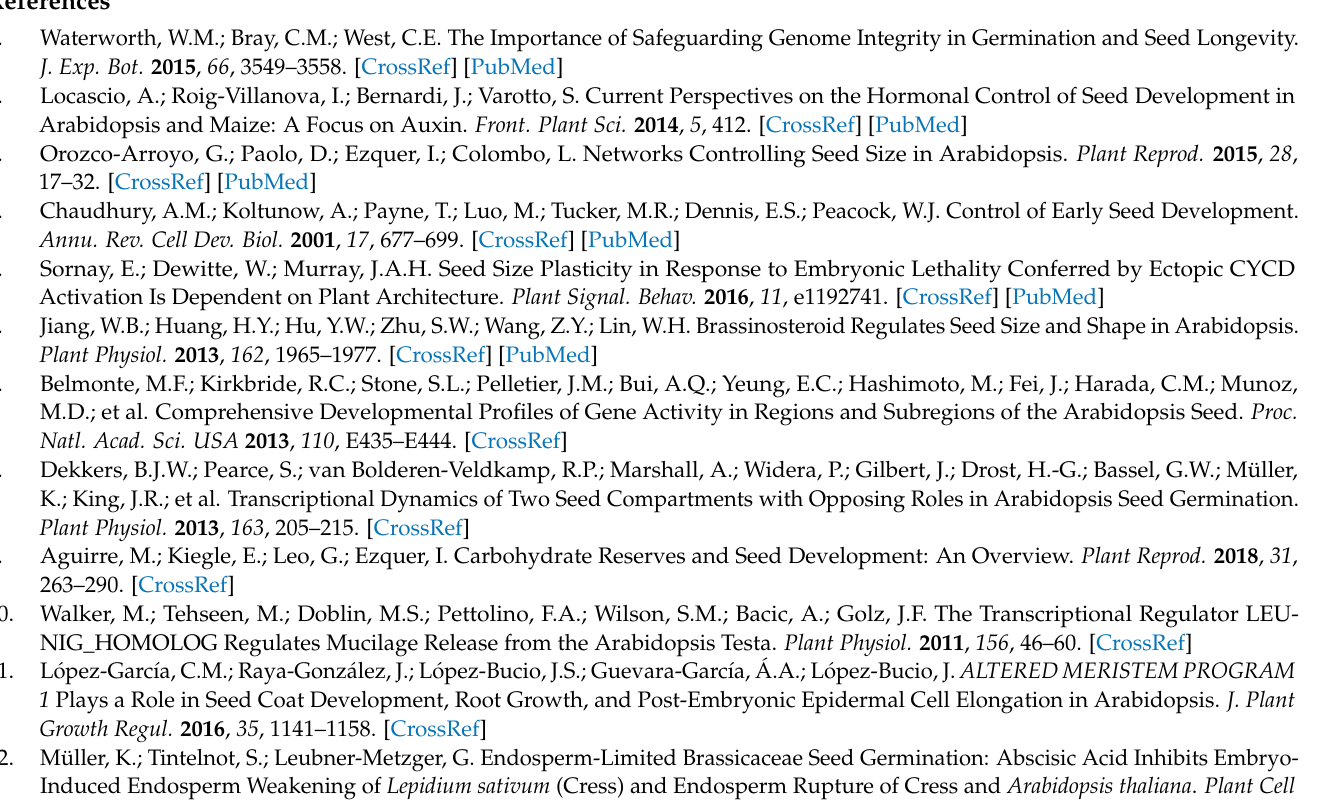
Figure S3: Ruthenium red staining in seeds from the cell wall mutants for the mucilage extrusion analysis; Scale bar = 100 µ m; Figure S4: Vanillin staining in seeds from the cell wall mutants for the proanthocyanidin accumulation analysis; Scale bar = 50 µ